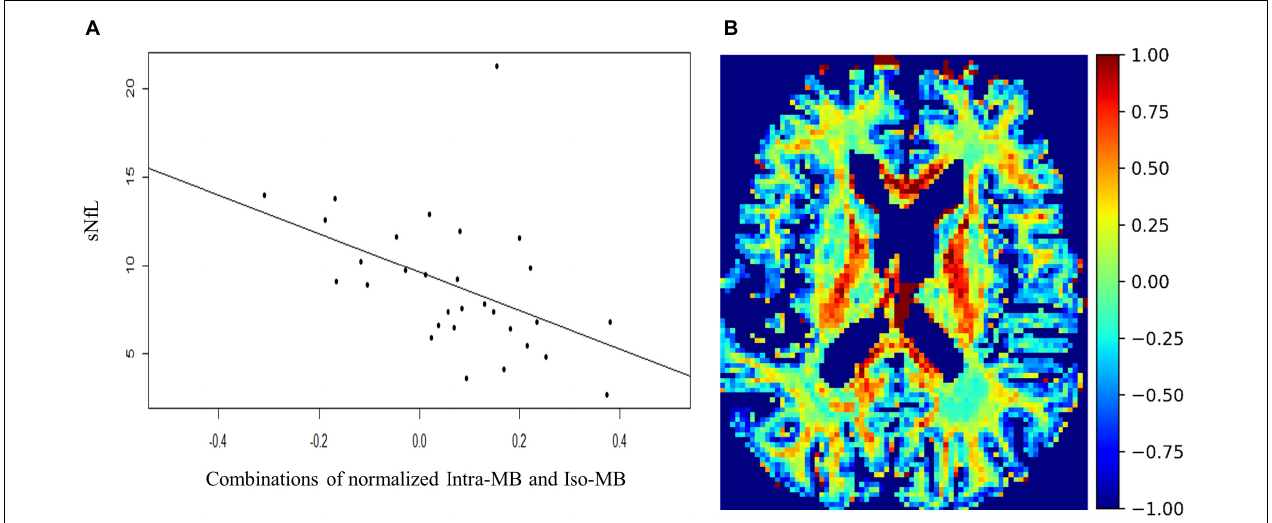
FIGURE 5 | (A) Scatter plot and a regression line of the combinations of normalized Intra-MB and Iso-MB, which showed the strongest correlation with sNFL. (B) An exemplary image of the combined